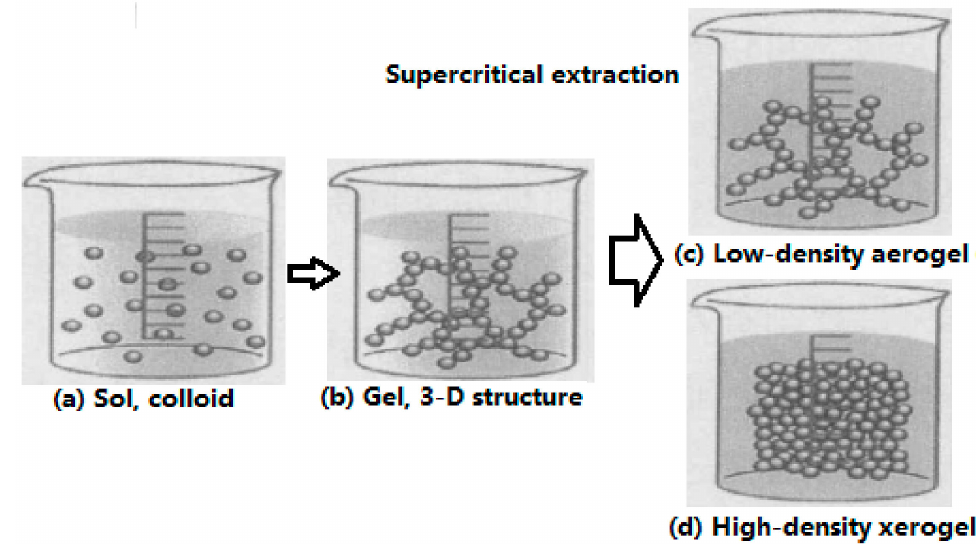
Figure 1. Typical process for sol–gel method preparation. ( a ) Sol, colloid; ( b ) Gel, 3D structure; ( c ) Low-density aerogel; ( d ) High-density xerogel. Reproduced from [12], with permission from Elsevier,